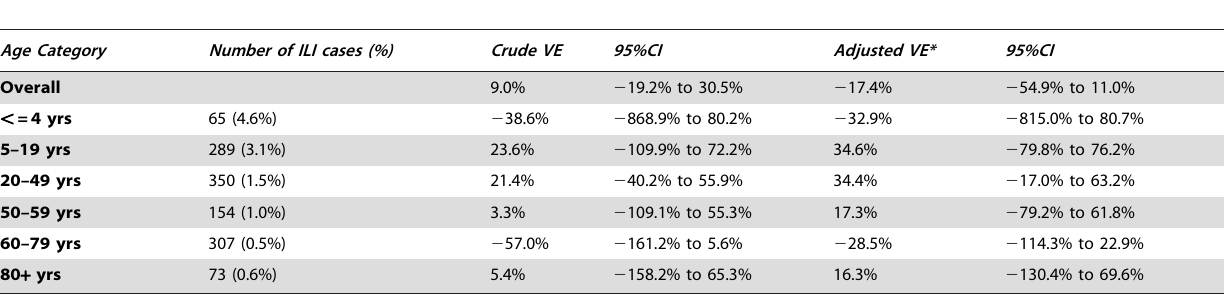
Table 4. Crude and adjusted pandemic H1N1 vaccine effectiveness per age category: Post hoc Time Dependent Analysis with baseline at